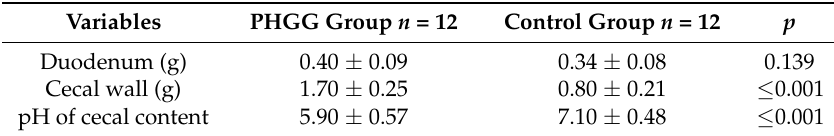
Table 4. Weight of the duodenum and cecum and pH of the cecal content in the animals of the PHGG and control